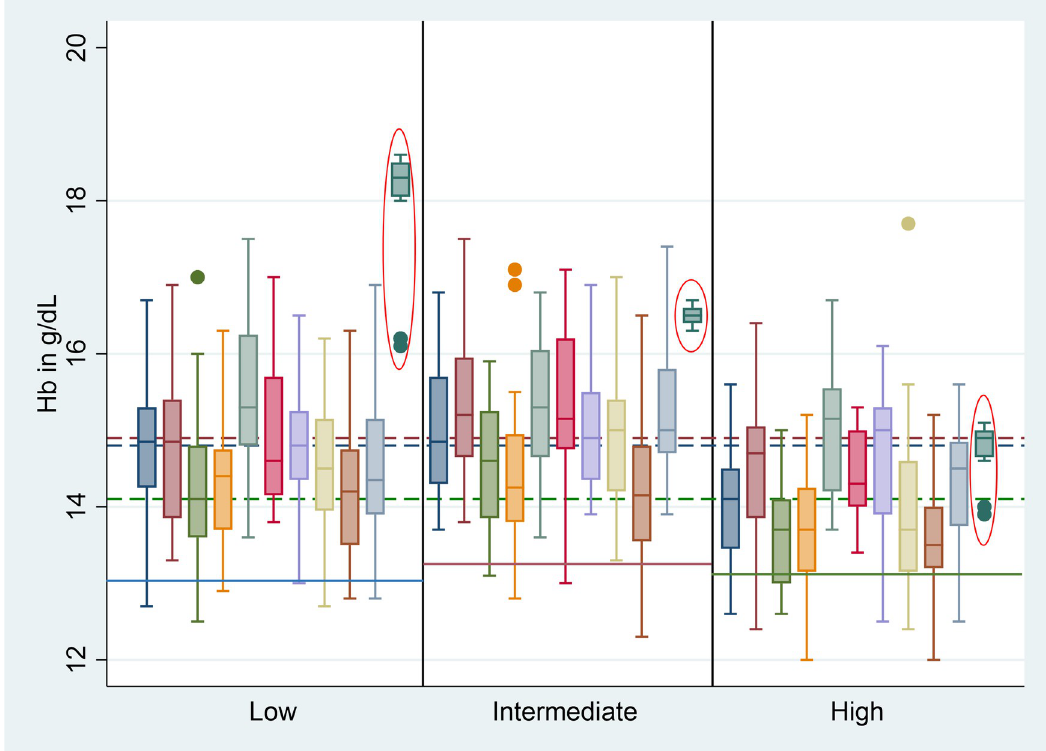
Fig 3. Hb levels measured by each Biosensor device and Hemocue. Red circled bars = reference method (Hemocue), Blue line = recommended point estimate for ACS Low controls, Red line = recommended point estimate for ACS Intermediate controls, Green line = recommended point estimate for ACS High controls, Blue dotted line = median Hb reading for Low controls, Red dotted line = median Hb reading for Intermediate controls, Green dotted line = median Hb reading for High controls, dots represent outliers.